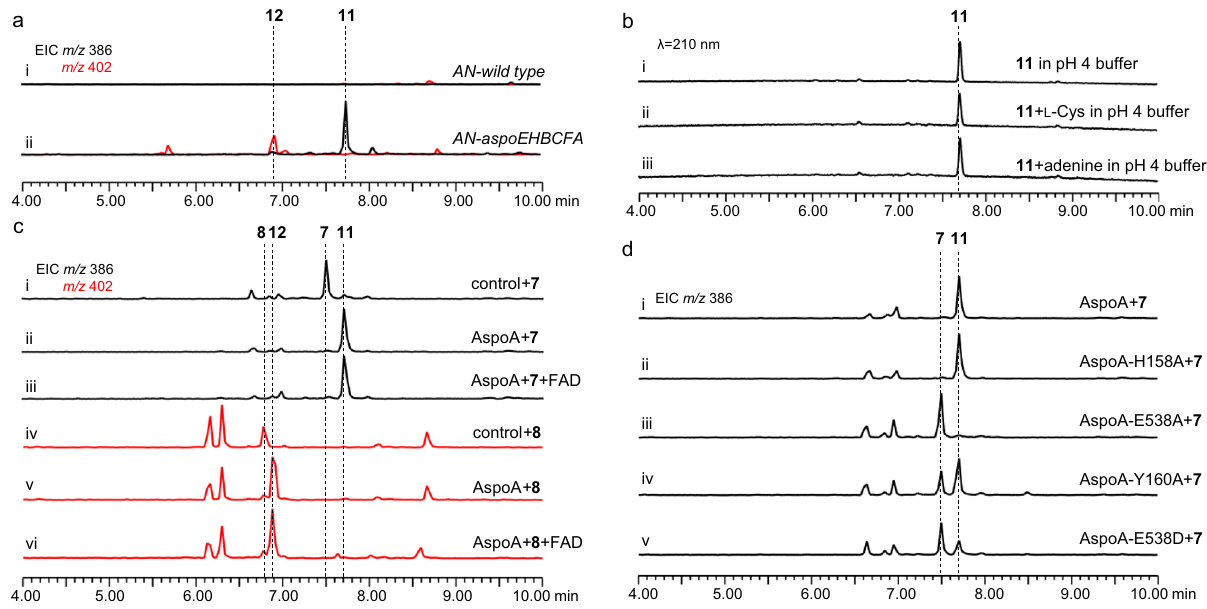
Fig. 5 Con fi rmation of the function of gene aspoA . a LC-MS analyses of the culture extracts from the A. nidulans transformants. b Compound 11 could not undergo nonenzymatic conversions under acidic conditions. c In vitro biochemical assays showed that AspoA catalyses the isomerization of 7 or 8 to 11 or 12 , respectively, where the exogenous addition of FAD does not increase the activity of AspoA. d Identi fi cation of the key amino acid residues in AspoA for double bond isomerization by site-directed mutation. Mutation of the classical endogenous FAD binding residue His 158 does not decrease the activity of AspoA. Site-direct mutagenesis demonstrated that Glu 538 is essential for AspoA activity. The EICs were extracted at m/z 386 [M + H] + for 7 and 11 , m/z 402 [M + H] + for 8 and 12